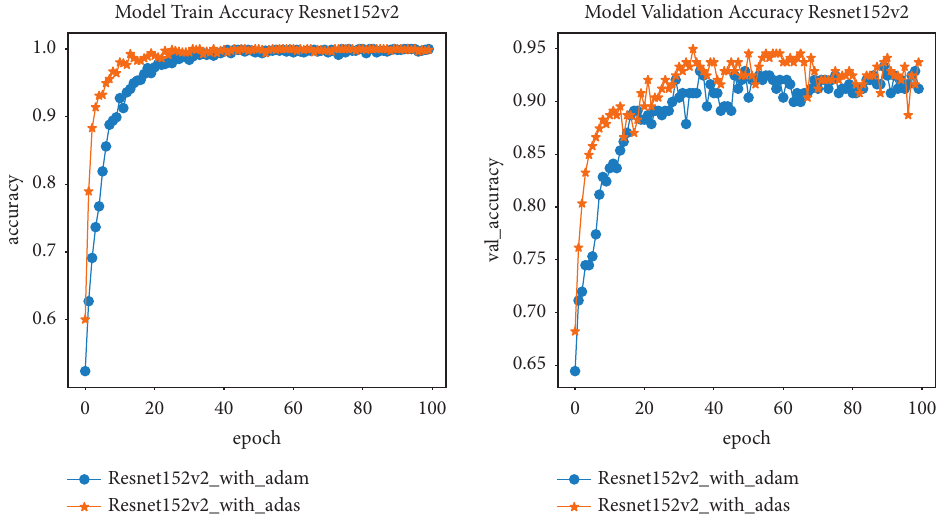
Figure 18: Accuracy of ResNet152V2 network architectures using ADAM and ADAS optimization algorithms.